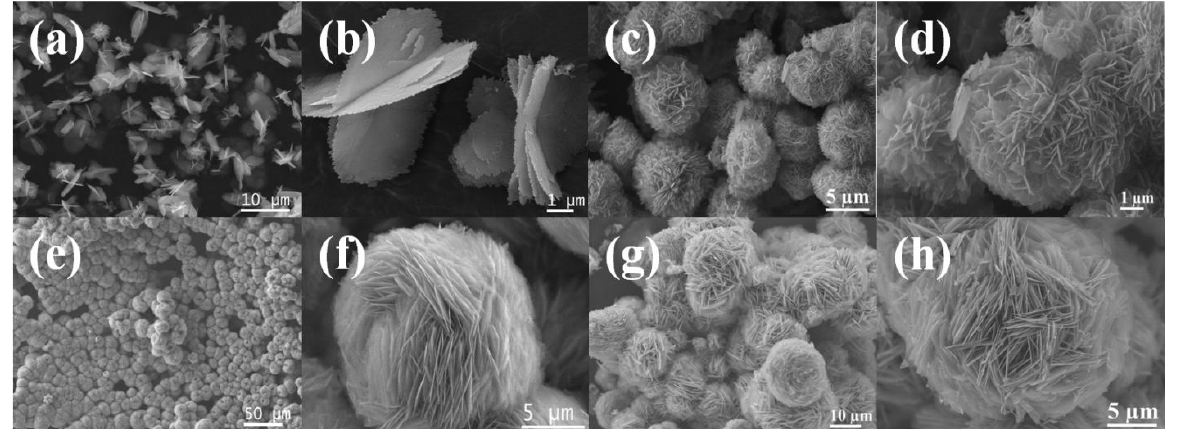
Figure 2. SEM images of ZnO samples F1–F4 prepared with different Zn 2+ concentrations: ( a , b ) 0.008 M; ( c , d ) 0.016 M; ( e , f ) 0.033 M and ( g , h ) 0.066